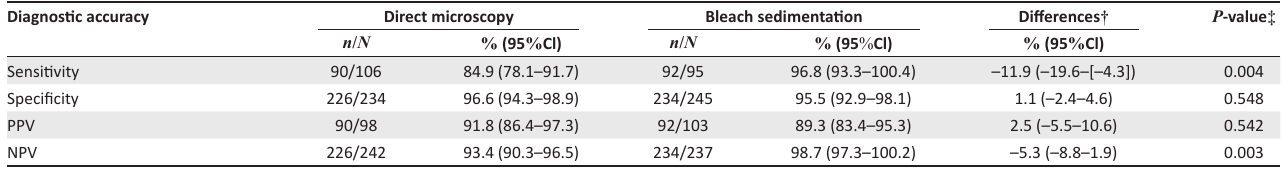
TABLE 4: Diagnostic accuracy of direct microscopy and bleach sedimentation-treated sputa compared with Lowenstein-Jensen culture following sodium hydroxide decontamination, Abuja, Nigeria, November 2004 to July 2005. Diagnostic